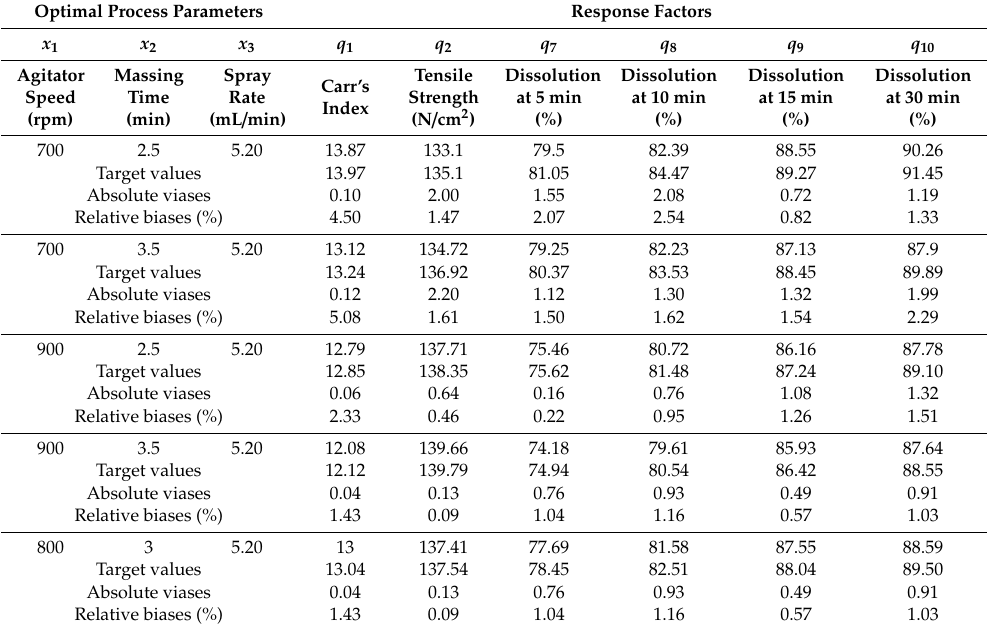
Table 4. Optimal process parameters, target values, and validated results at the lab scale for the response factors Optimal Process